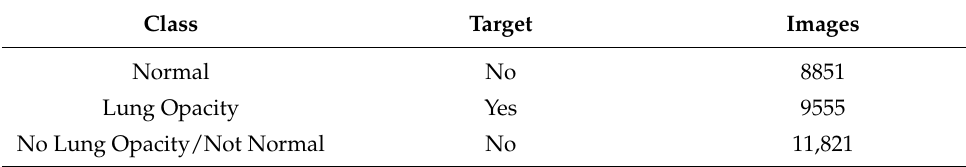
Table 1. Distribution of the RSNA CXR image